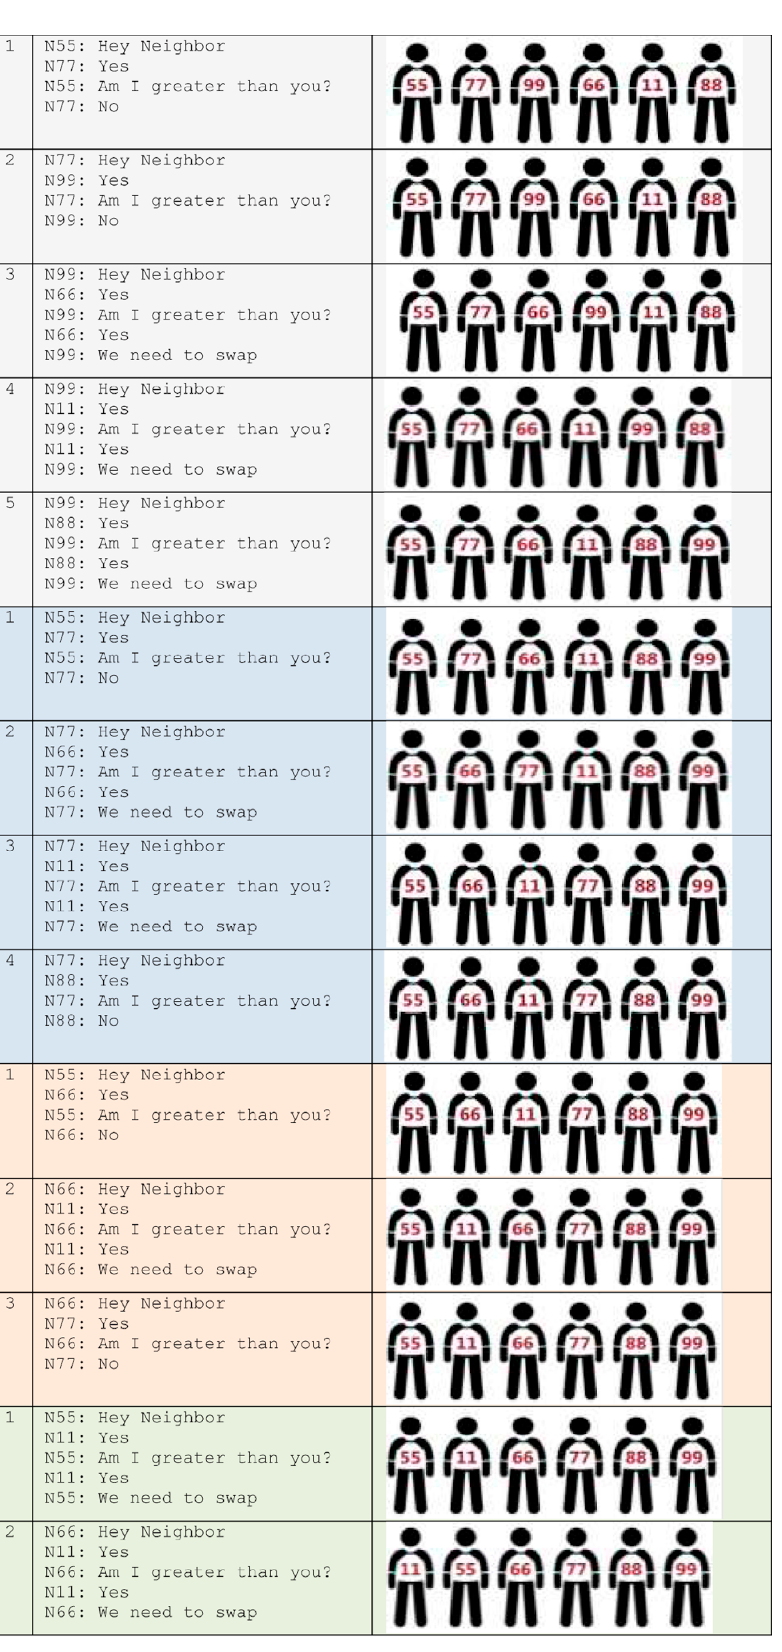
Figure 3. Bubble Sort Class Activity.